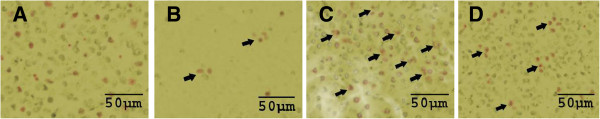
Immunohistochemical expression pattern of Bcl-2 in mid brain. A: Control (group 1); B: MPTP induced (group II); C: MPTP induced + As treated (group III); D: Drug Control (group IV).